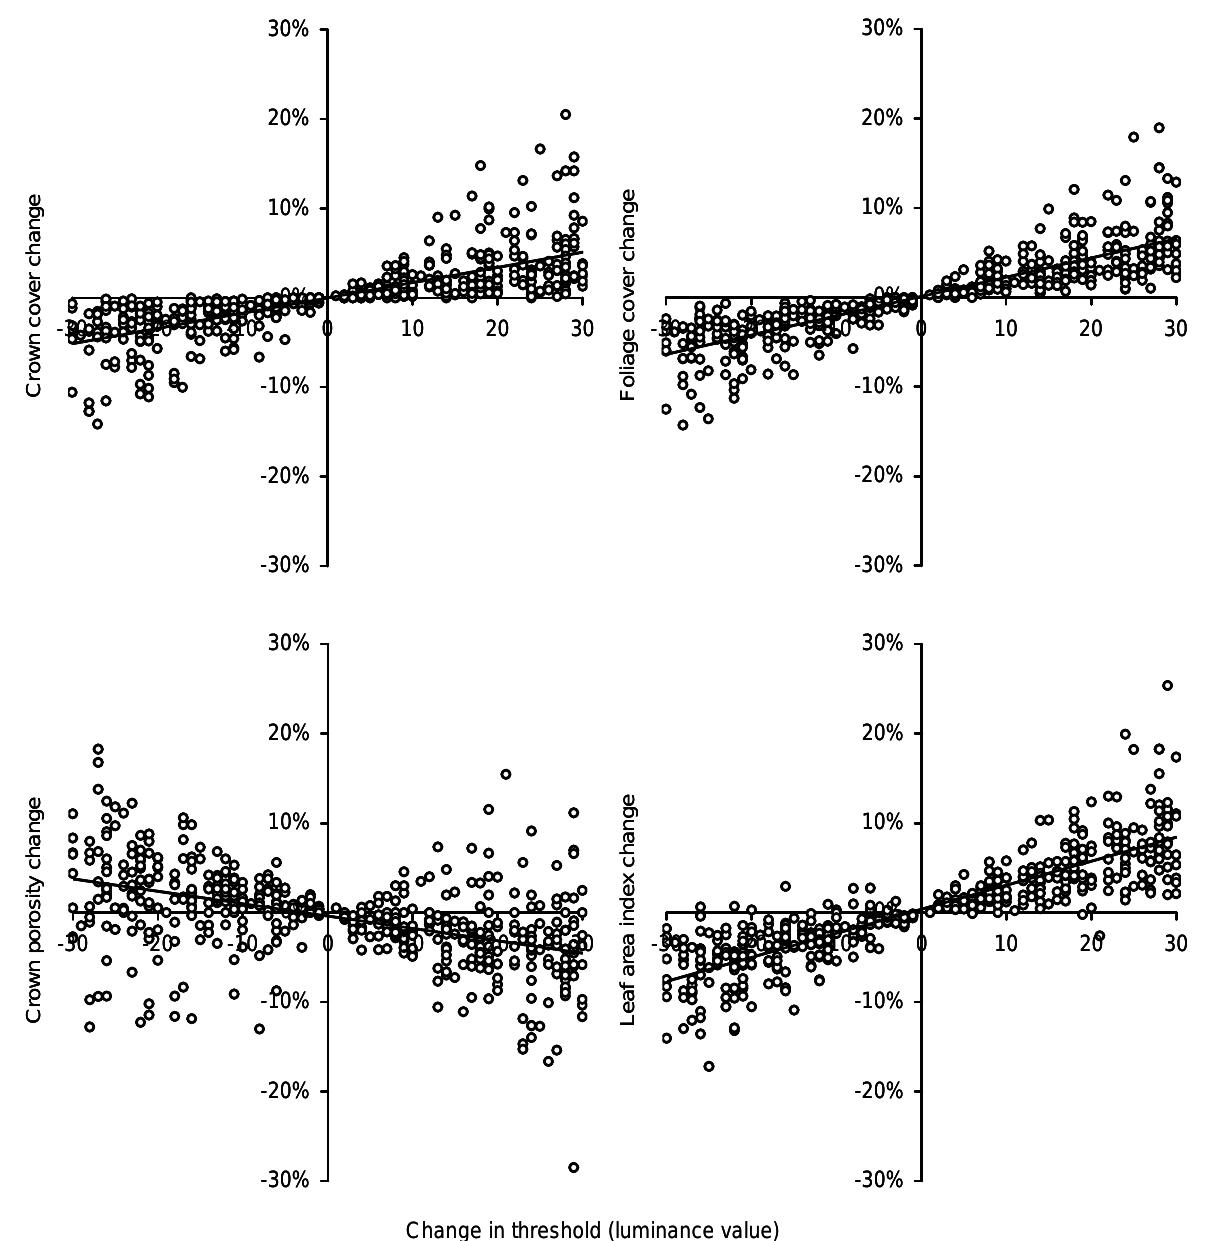
Figure 6. The percentage change of crown cover, foliage cover, crown porosity and leaf area index in response to a changed threshold used to segment images into sky and foliage. The Threshold change is the absolute difference between the automatic threshold selected by WinSCANOPY and the manual threshold used for